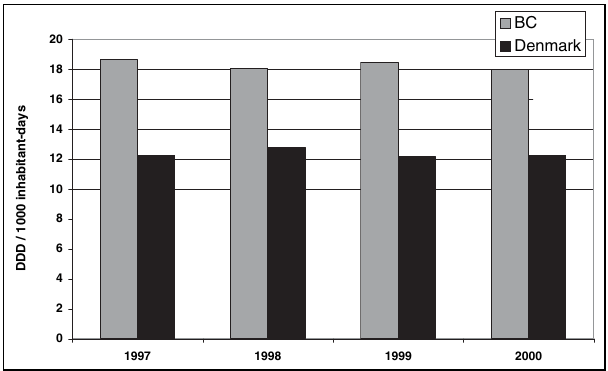
Figure 3) J01 Antibiotic consumption in ambulatory care patients in British Columbia, 1997 to 2000. DDD Defined Daily Dose